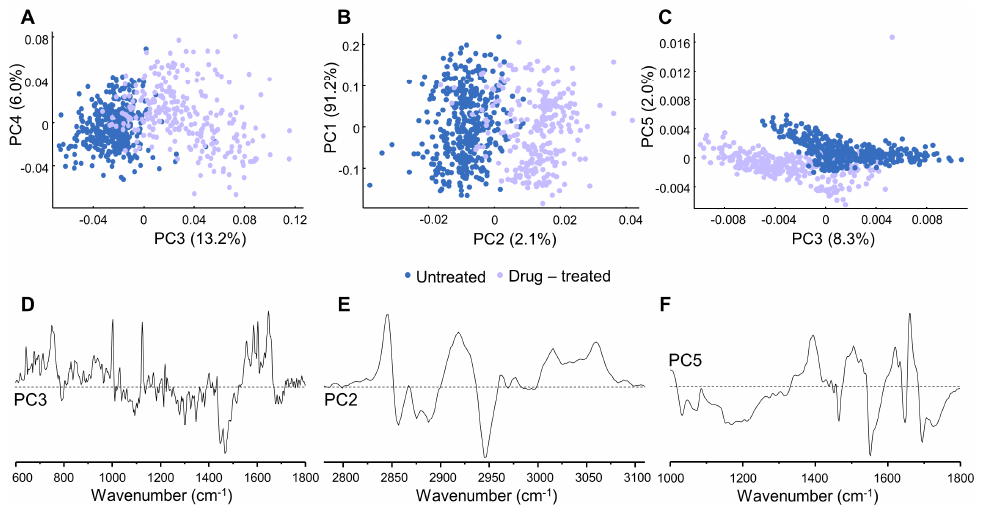
Figure 5. PCA scores and loading plots of Raman (( A , D ) 600–1800 cm − 1 and ( B , E ) 2700–3200 cm − 1 ) and FTIR (( C , F ) 900–1800 cm − 1 ) data for [Pt 2 Put 2 (NH 3 ) 4 ] 4+ -treated lung cancer cell line (A549) vs. control (untreated cells). For clarity the loadings are offset, the dashed horizontal lines indicating zero loading.